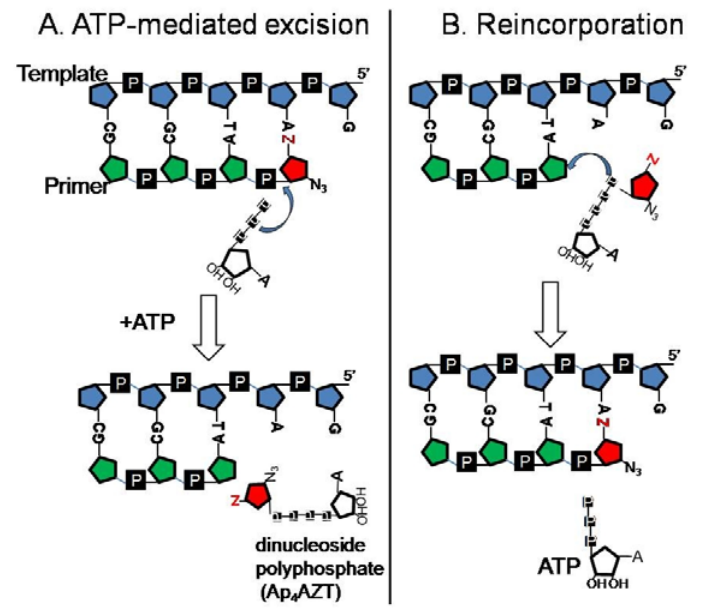
Figure 1. ATP-mediated excision of AZTMP and the use of Ap AZTMP incorporation. (A) ATP attacks the phosphodiester bond removing the drug-MP from the primer terminus, forming a dinucleoside polyphosphate and an unblocked primer AZT is recognized as an analog of AZTTP leading to incorporation of [32]. (B) Ap 4 AZTMP and release of ATP [34,35]. The template and primer are shown in blue and green, respectively; AZT is in